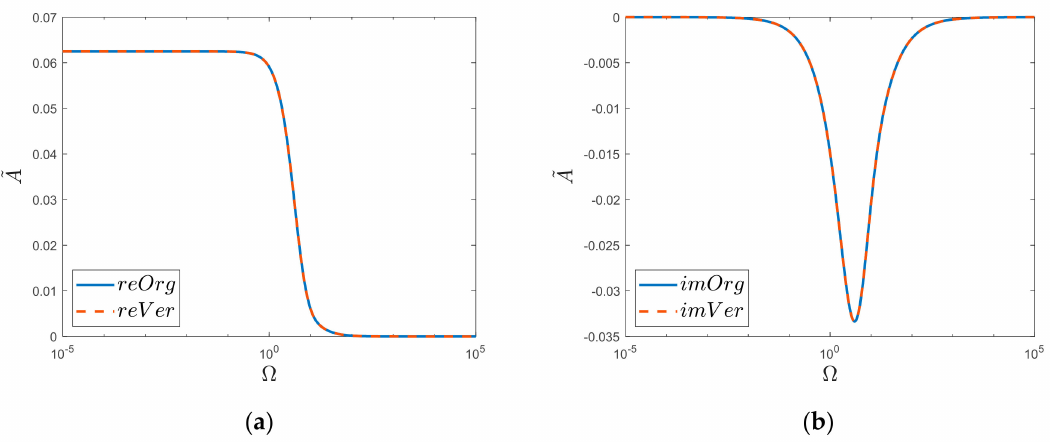
Figure 3. ( a ) Realis and ( b ) Imaginaris graphs of original function “ Org ” and newly derived substitute “ Ver ”. Semi − log scale for k = 2